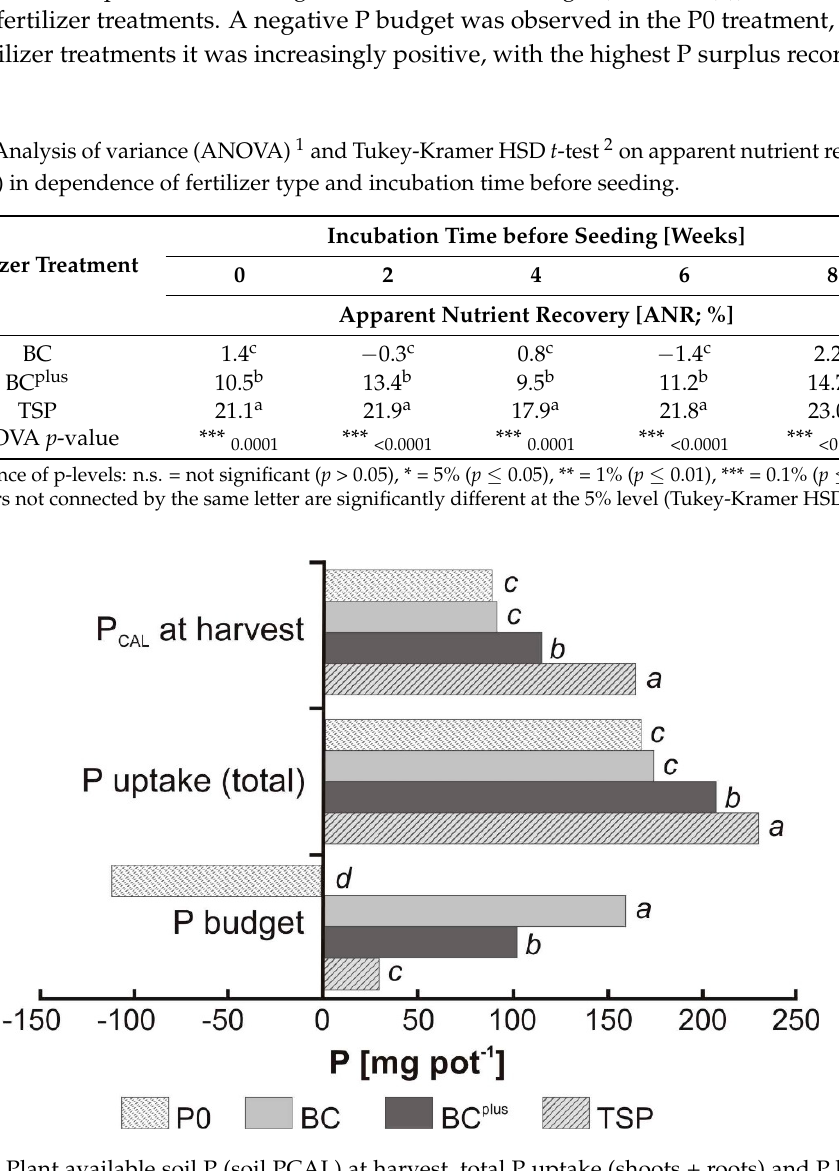
Figure 4. Plant available soil P (soil PCAL) at harvest, total P uptake (shoots + roots) and P budget (Formula (2)) of annual rye grass per pot across all incubation times. Levels not connected by the same letter are significantly different at the 5% level (Tukey-Kramer HSD t -test).